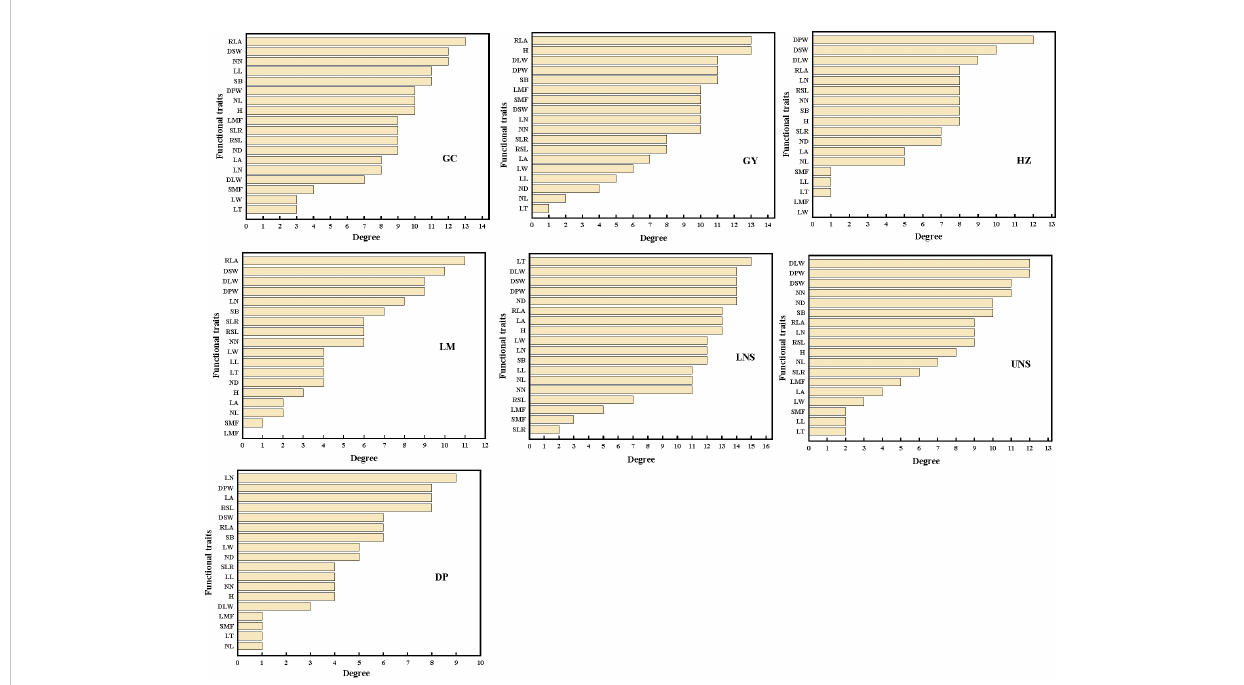
FIGURE 3 The degree of functional traits in plant trait network of impounded lakes and Grand Canal. GC, GY, HZ, LM, LNS, UNS and DP are abbreviations for Grand Canal, Gaoyou Lake, Hongze Lake, Luoma Lake, lower Nansi Lake, upper Nansi Lake and Dongping Lake, respectively.